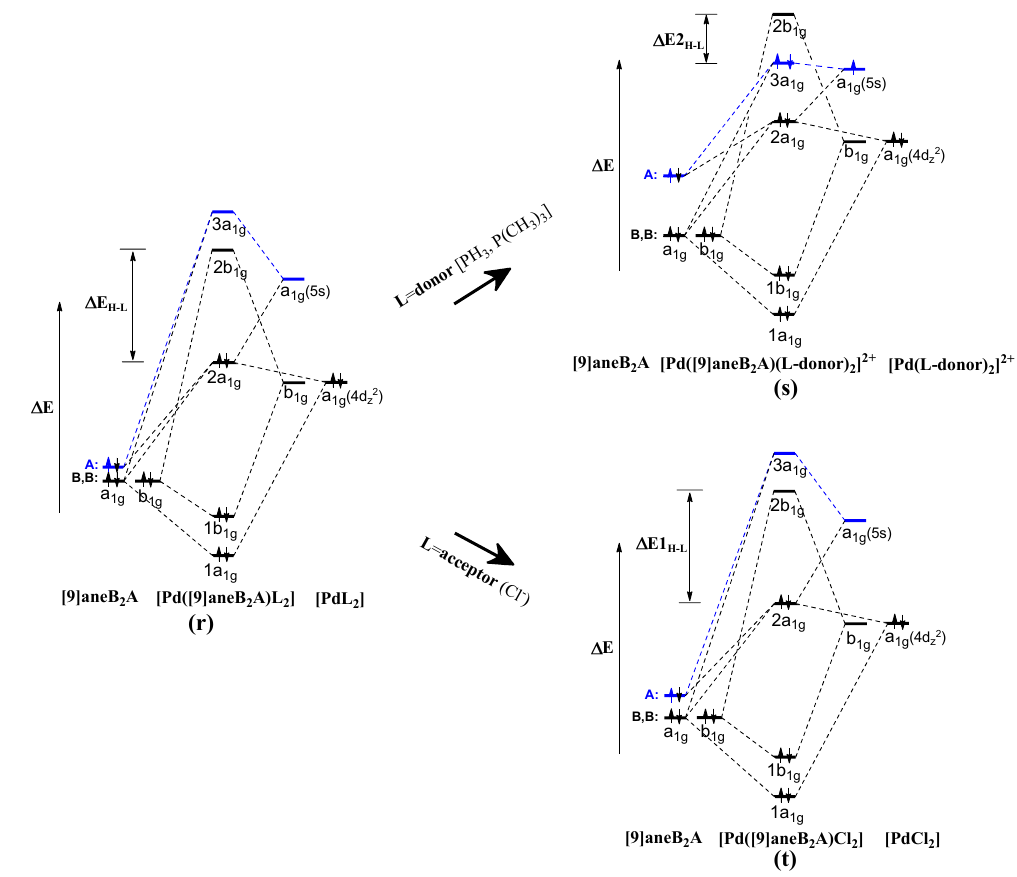
A to [Pd( L -donor) 2 A )( L -donor) ] 2+ complex (r) , the separated configuration of two 2 2 -orbital indicates the ( A --Pd) quasi-bond. 1g